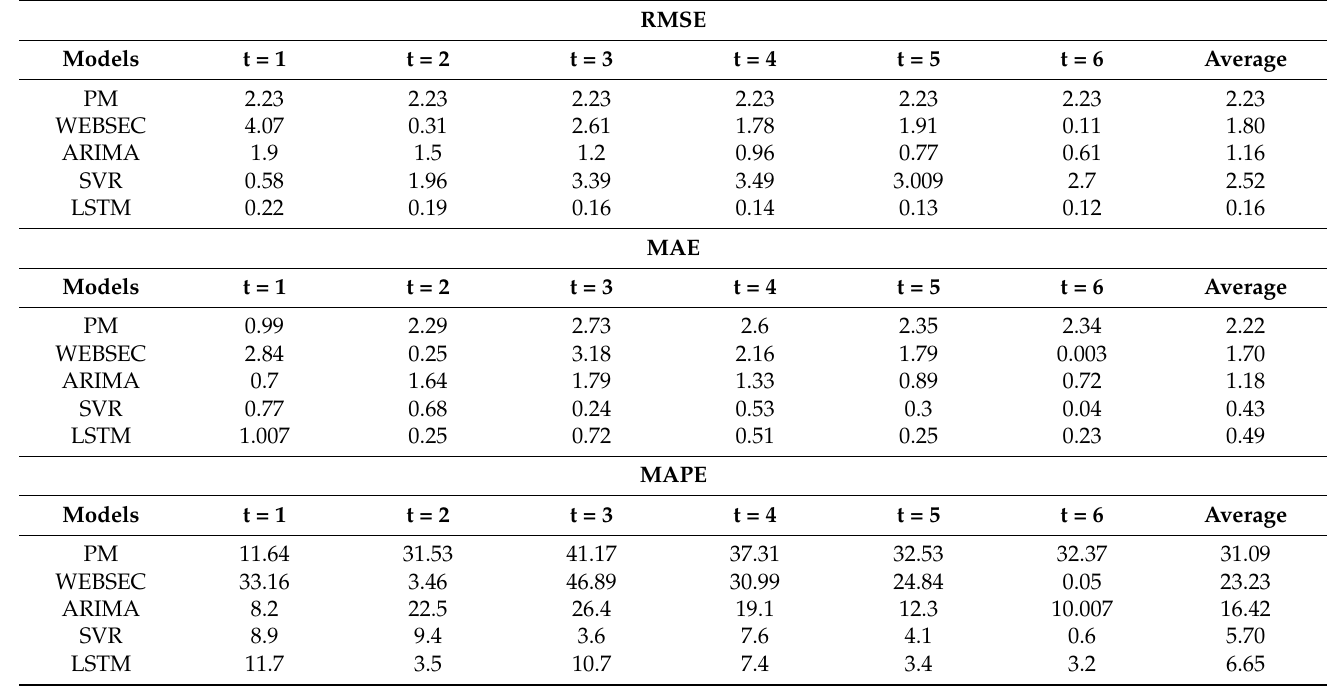
Table 8. Performance results of different univariate WSP models for West Virginia Hills region. RMSE